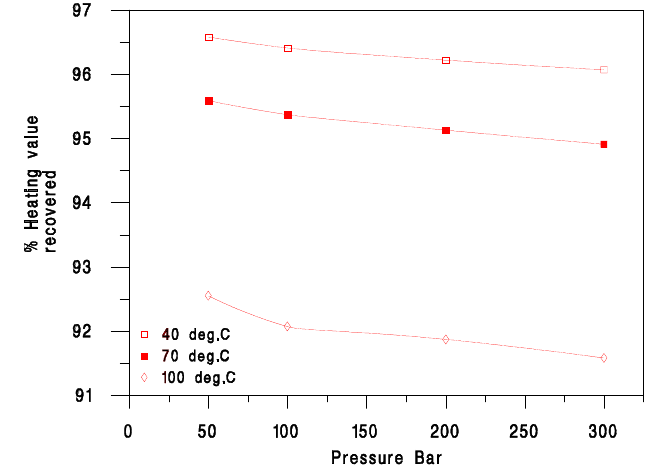
Figure 8. Effect of air pressure on heating value recovery of Prince of Wales coal.